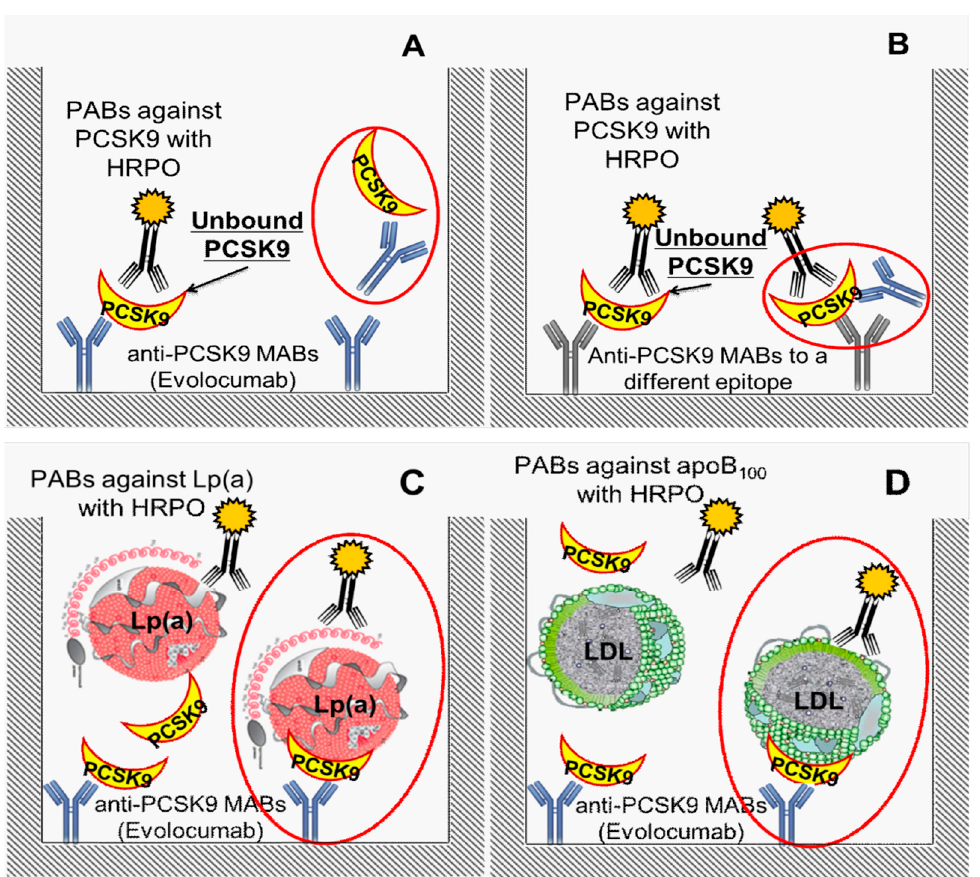
Figure 2. ELISA scheme for measuring: ( A ) PCSK9 not associated with MABs, ( B ) total pool PCSK9 unbound from and bound with MABs. Red circles highlight the complex of PCSK9 with MABs (Evolocumab); ( C ) PCSK9-Lp(a) and ( D ) PCSK9-apoB100 complexes. Red circles are demonstrated horseradish peroxidase (HRPO). Abbreviations: PCSK9—proprotein convertase type 9 subtilisin/kexin, MABs—monoclonal antibodies, PABs—polyclonal antibodies, HRPO— horseradish peroxidase, LDL—low density lipoproteins.